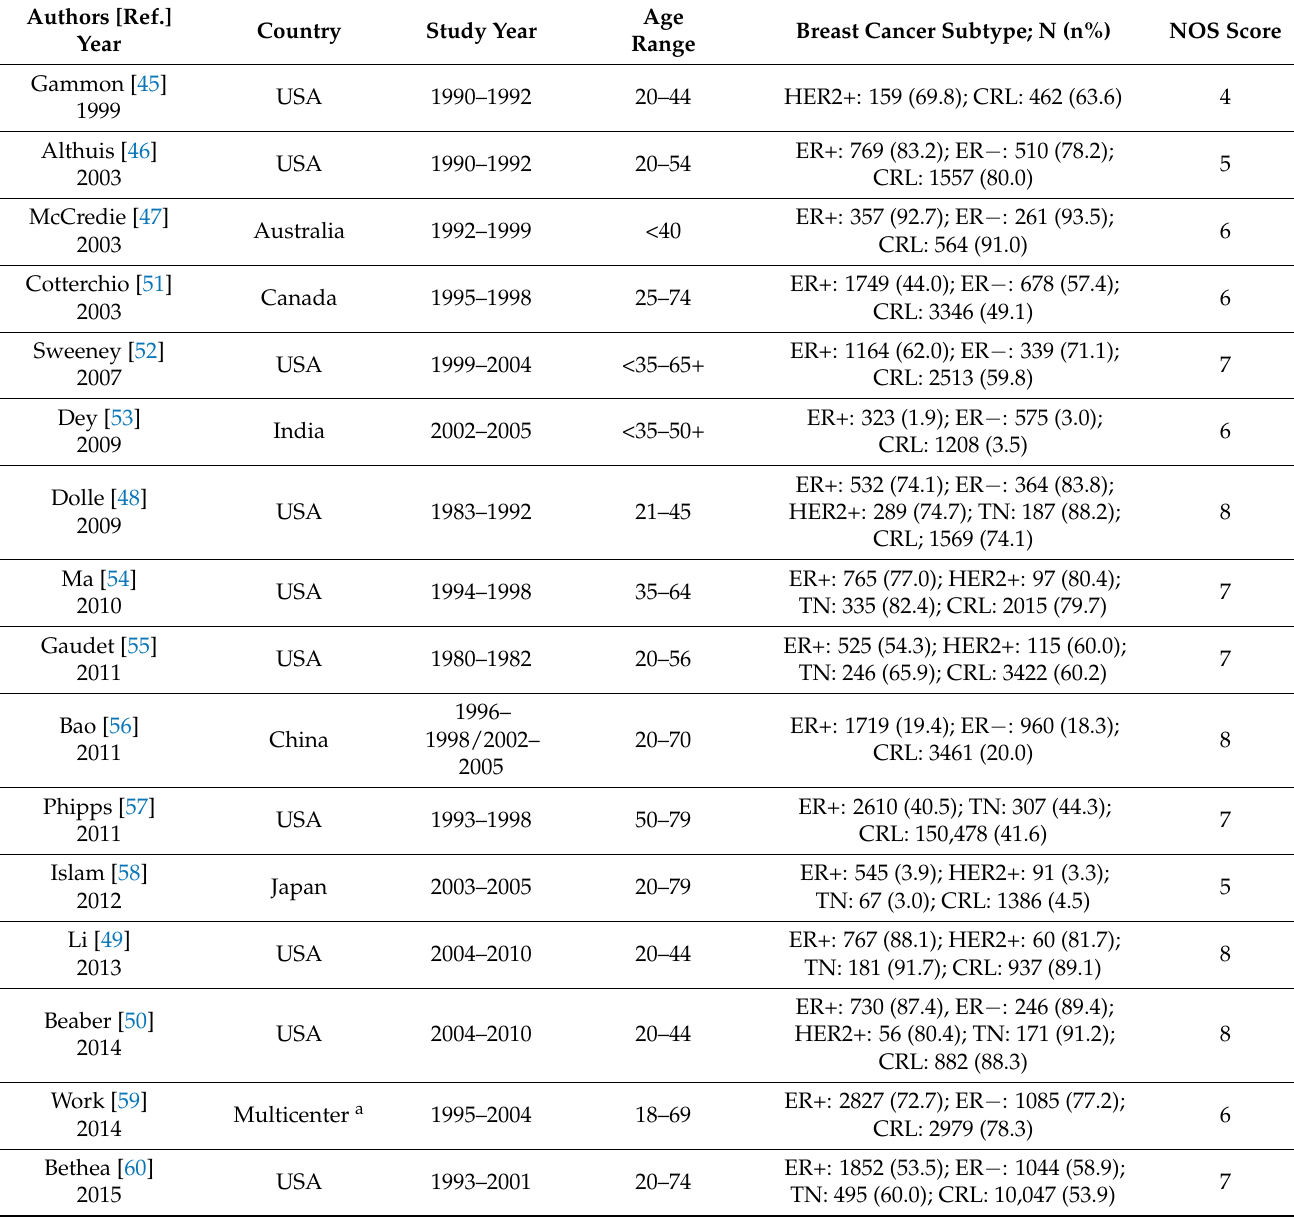
Table 1. Characteristics of selected cases-control studies assessing effects of oral contraceptive use on risk of molecular breast cancer